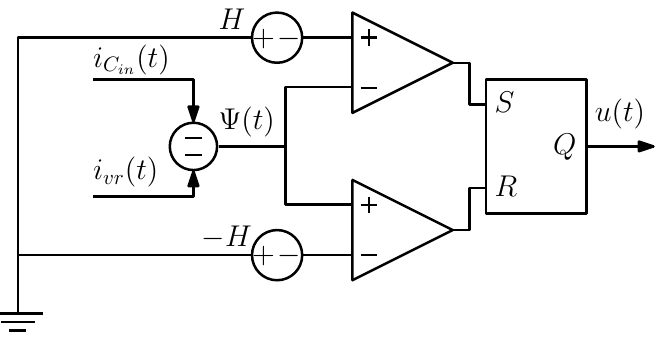
Figure 6. Sliding surface and control law of the